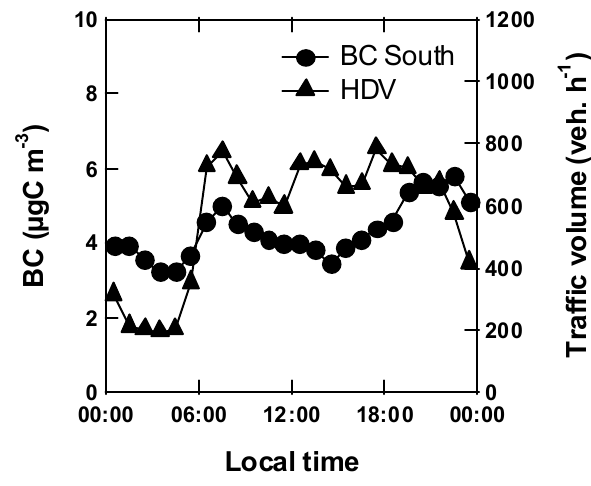
Fig. 6. Diurnal variations of hourly BC and heavy-duty vehicles (HDV) in Guangzhou. The traffic volume of HDV is an hourly average, recorded during 18–24 July 1999, and 12–18 October 1999 on the Dongfeng middle road, (Xie et al.,